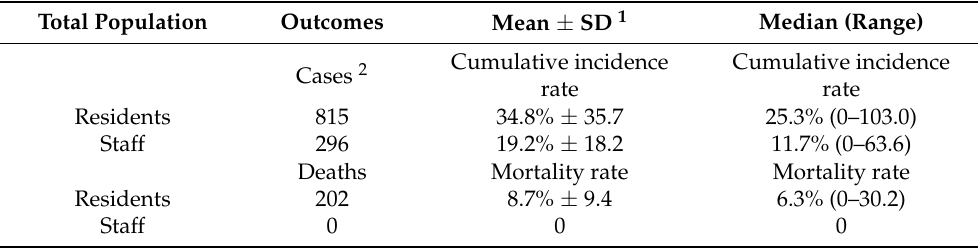
Table 2. Incidence and mortality of COVID-19 in nursing homes of Health Departments 2 and 3